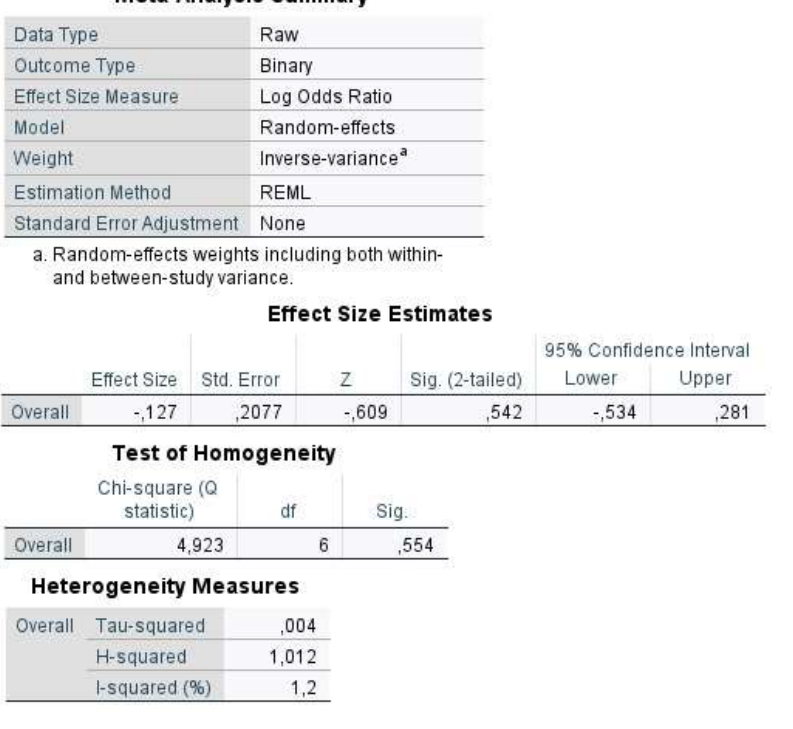
Figure 11. Output for Binary Data.